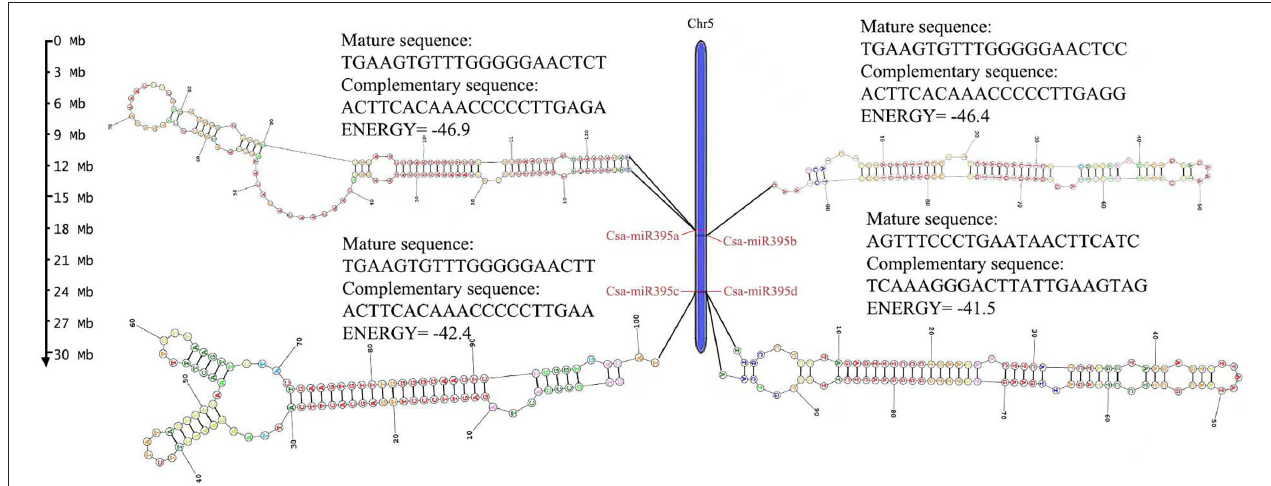
FIGURE 1 | Chromosome localization of Csa-miR395s. The scale was in megabases (Mb). The secondary structure and mature sequences of Csa-MIR395s were provided.